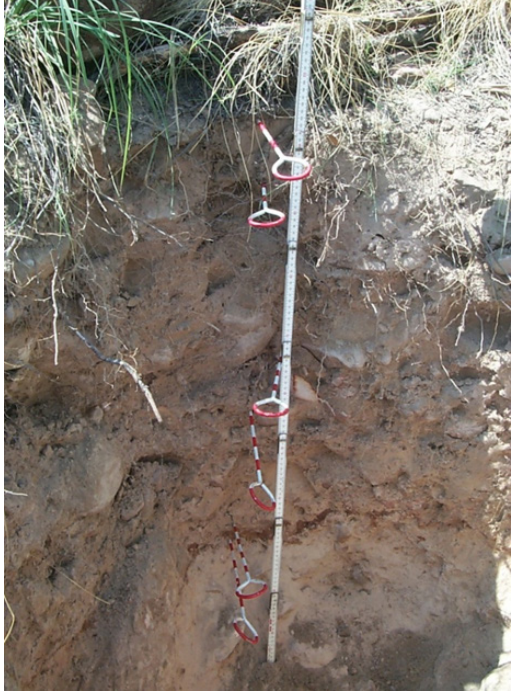
Figure 4. Soil horizon depths exhibited high variability both within and across parent material